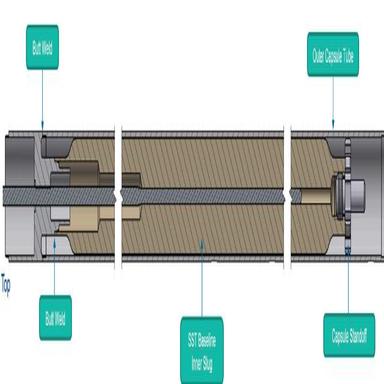
Shows a cross-section view of the IMPACT SST baseline outer capsule assembly.